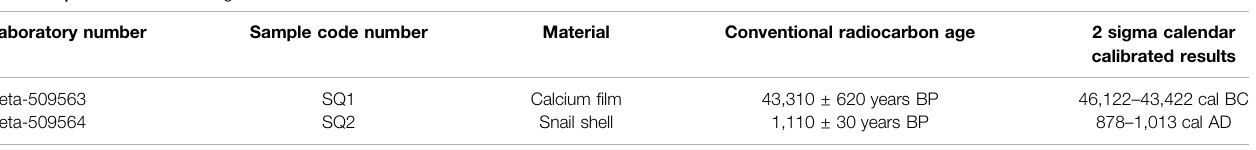
Frontiers in Earth Science |